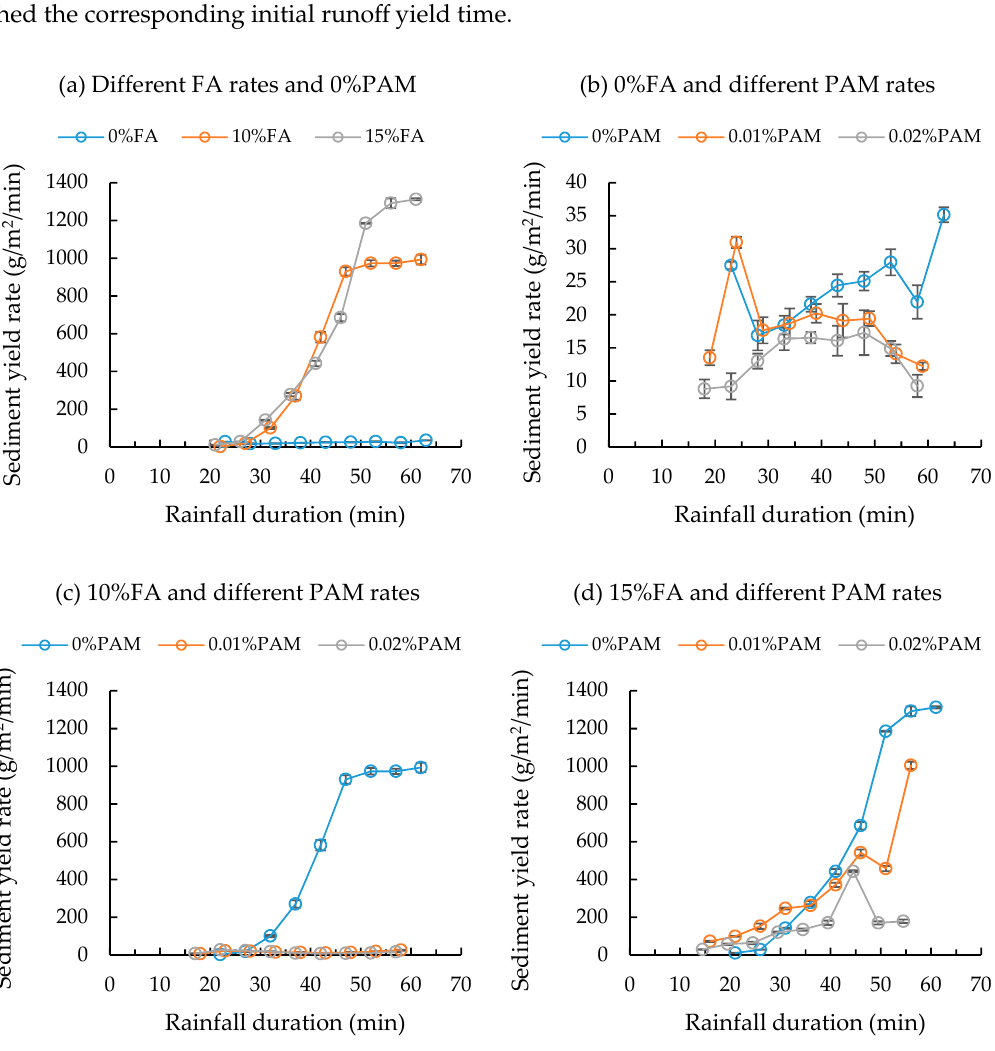
Figure 5. Changes in instantaneous sediment yield rate with rainfall duration for di ff erent treatments. The error bars represent one standard deviation ( n =